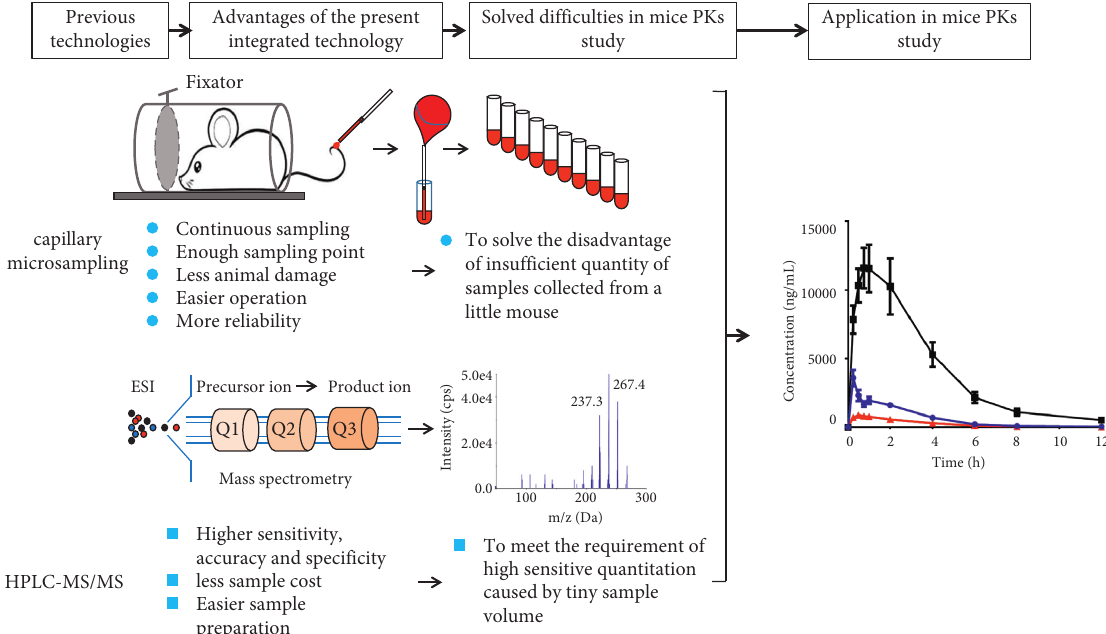
R3G, trans-resveratrol-3-o- β -glucuronide; R3S, trans-resveratrol-3-sulfate salt; AUC (0-12) , area under the plasma concentration-time curve from 0 to 12 hours; AUC (0– ∞ ) , area under the plasma concentration-time curve from 0 to infinity hours; T max , time to peak concentration; C max , maximal concentration; t 1/2 , eliminate half-life.